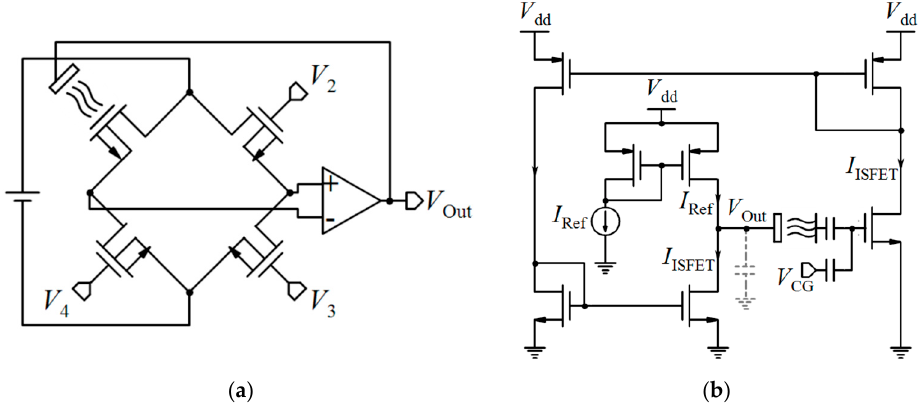
Figure 23. ( a ) Direct Wheatstone-bridge; ( b ) the circuit used for the characterization of ISFET drift in the feedback mode.